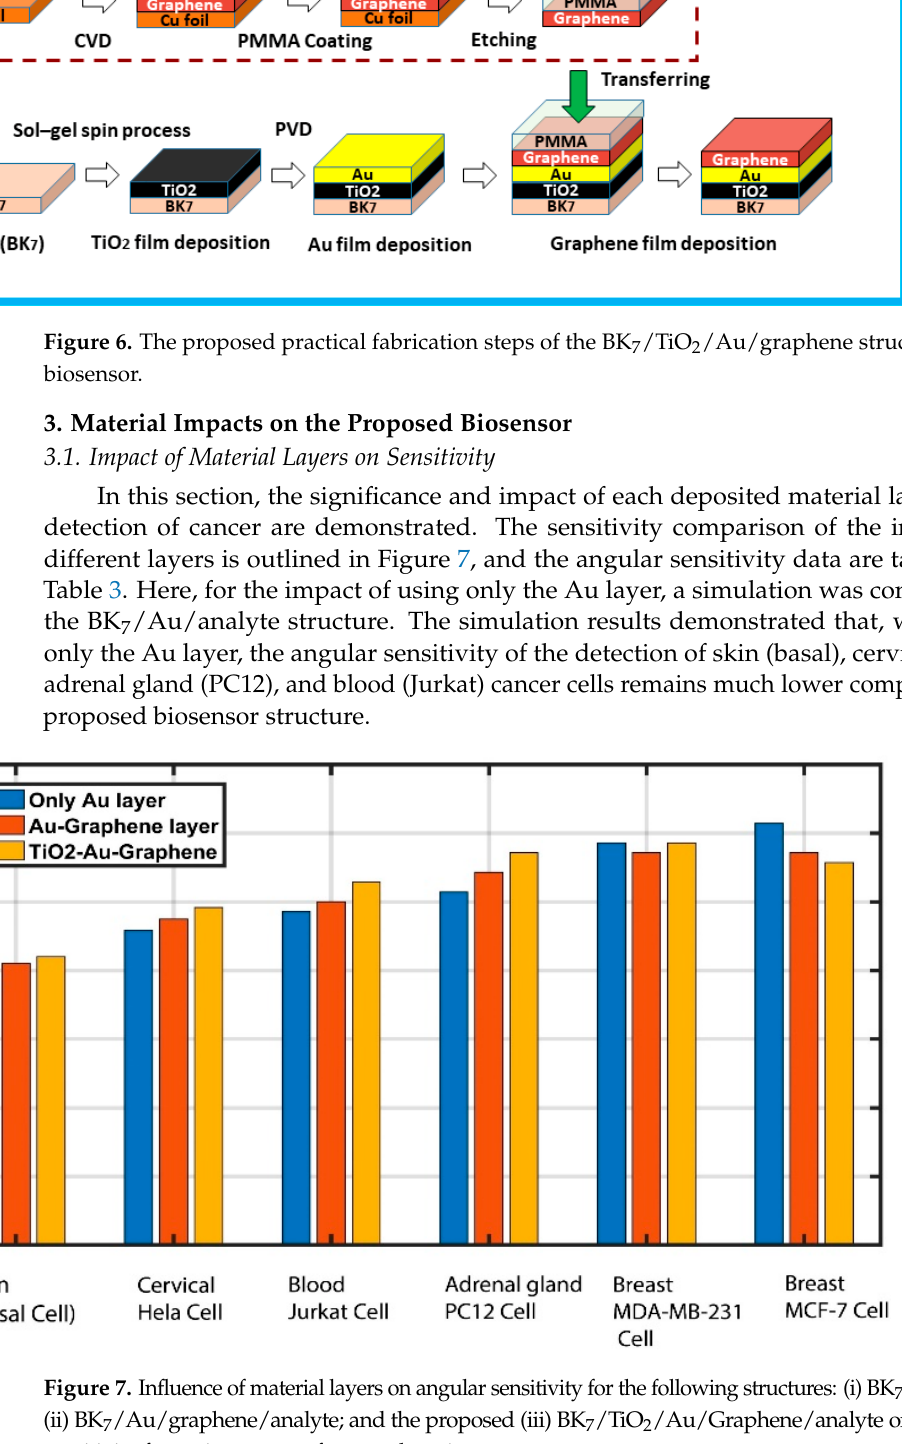
Biosensor Structures